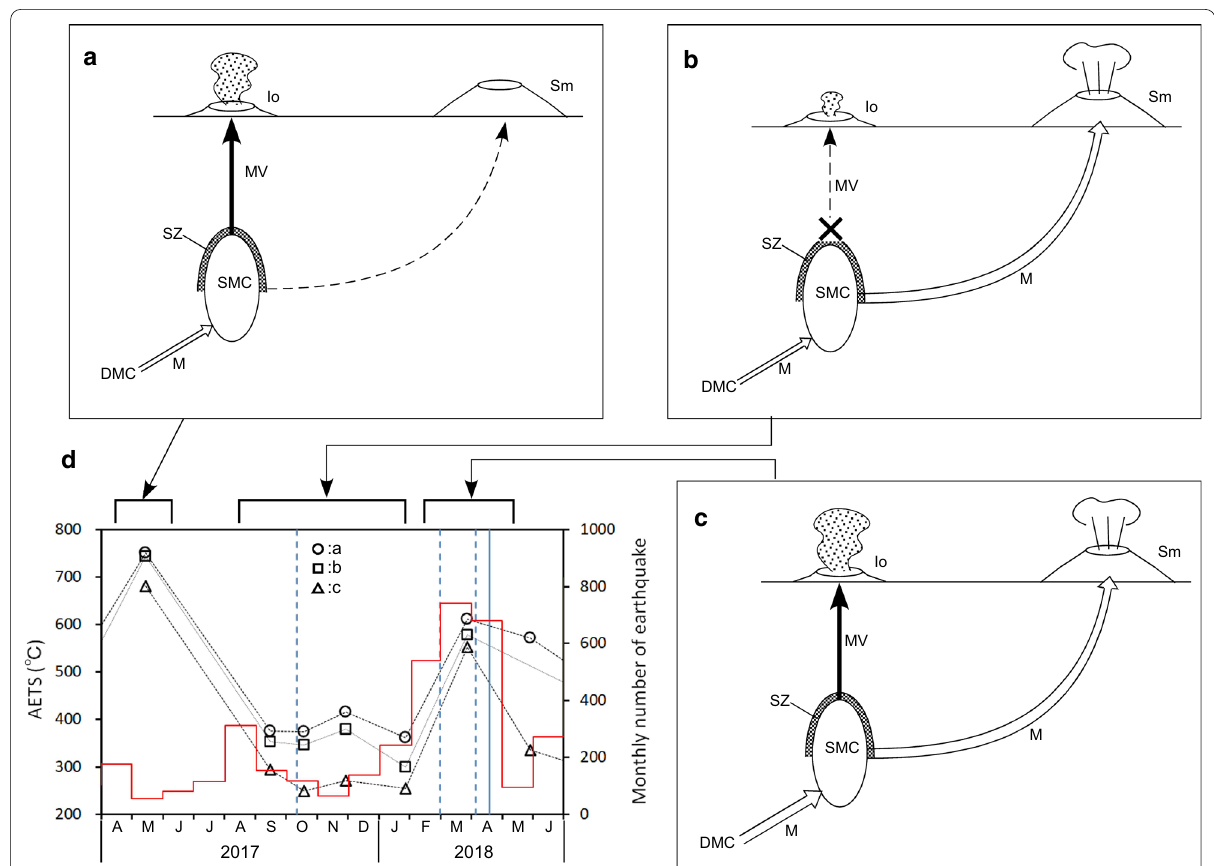
Fig. 7 Magma degassing and transport estimated from the correlation between changes in AETS and eruptions at Shinmoedake volcano (Sm). a Local situation in May 2017. A large flux of magmatic vapor (MV) was supplied to the aquifer beneath Ioyama volcano (Io). No magma was transported to Sm from the shallow magma chamber (SMC). The sealing zone (SZ) surrounding the SMC was open. b Local situation between September 2017 and January 2018. MV emission was prevented by SZ. Simultaneously, magma (M) was transported to Sm, causing a magmatic eruption. c Local situation between February and April 2018. A break in the SZ caused a large flux of MV to be supplied to Io. Magma was also transported to Sm. The flux of magma from the deep magma chamber (DMC) is likely to have increased from February to April 2018. d Changes in the apparent equilibrium temperature (AETS). Red histogram and vertical lines have the same meaning as in Fig.